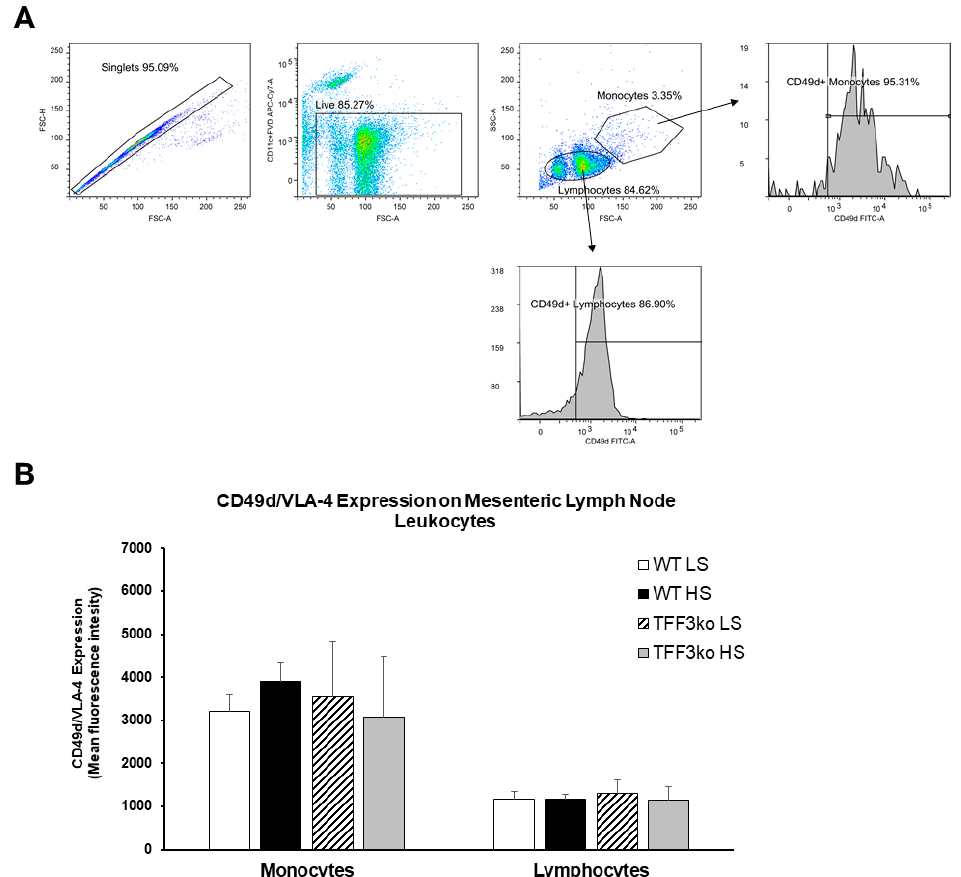
Figure 9. The effect of Tff3 deficiency and a 7-day high-salt (HS) diet on the integrin very late antigen- 4 (VLA-4) on mononuclear cells isolated from mesenteric lymph nodes (MLNs). ( A ) demonstrates the representative gating strategy, which included gating on live single cells followed by gating on lymphocytes and monocytes based on forward and side scatter. ( B ) shows the changing CD49/VLA-4 expression rates in MLNs. HS—high salt; VLA-4—very late antigen-4; MLNs—mesenteric lymph nodes; WT LS—wild-type (C57BL/6N) mice on a low-salt diet; WT LS—wild-type (C57BL/6N) mice on a high-salt diet; TFF3ko LS— TFff3 knock-out mice on a low-salt diet; TFF3ko HS— Tff3 knock-out mice on a high-salt diet. Data are presented as mean ± SD and were analyzed by one-way ANOVA or Kruskal–Wallis test where appropriate. In some cases, the effect of the diet on a particular strain (TFFko or WT) was tested by Student’s t -test or Mann–Whitney U test. p -values less or equal 0.05 are considered